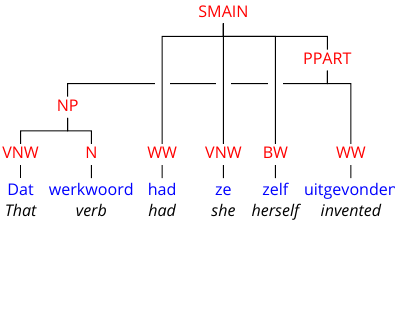
Figure 1: A tree from the Dutch Alpino treebank (van der Beek et al. 2002). PPART is a discontinuous constituent (indicated with crossing branches) due to its extraposed NP object. Part-of-speech tags: VNW=pronoun, N=noun, WW=verb, BW=adverb. The tags also contain additional morphological features not shown here that distinguish personal pronouns from others, auxiliary verbs from main verbs,